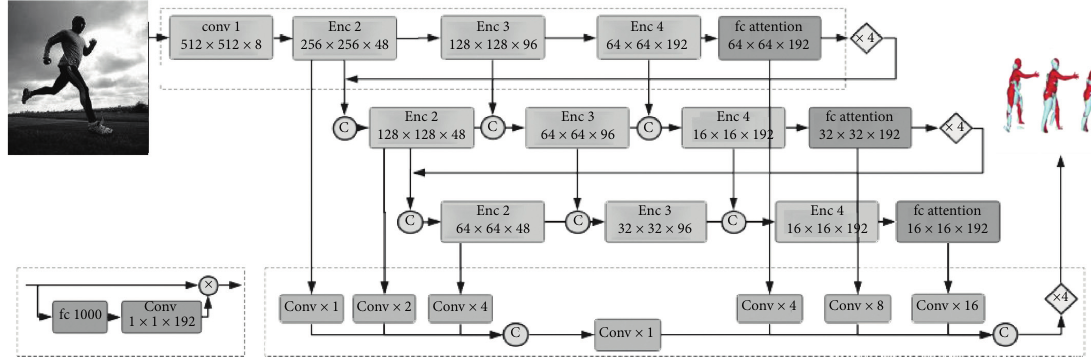
Figure 3: Flowchart of computer vision data transformation.